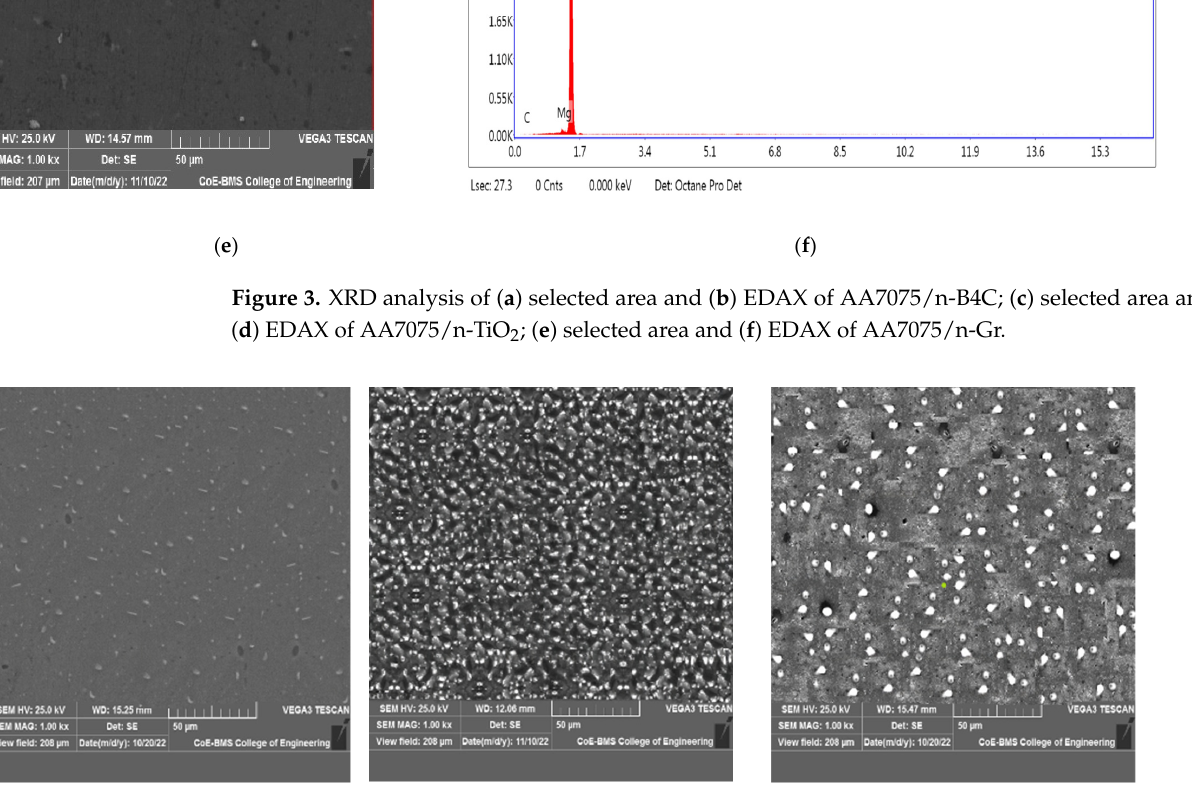
Figure 5. SEM images of a FSPed AA7075/ TiO 2 sample prepared at ( a ) 1400 rpm and 45 mm/min, ( b ) 2000 rpm and 35 mm/min, and ( c ) 2000 rpm and 45 mm/min. SEM images of the FSPed specimens with B 4 C made at feed rates of 25–45 mm/min and rotating speeds of 800–2000 rpm are shown in Figures 6a–c and 7a–c, respectively. The FSPed specimen’s cross-section revealed no flaws or porosities, but there was some aggregation of B 4 Cparticles, proving that the distribution of the particles in the aluminum matrix was not random. There were relatively few faults apparent in the interface, and it appeared that the surface composite layer was extremely effectively bound to the alumi- num alloy AA7075 substrate.